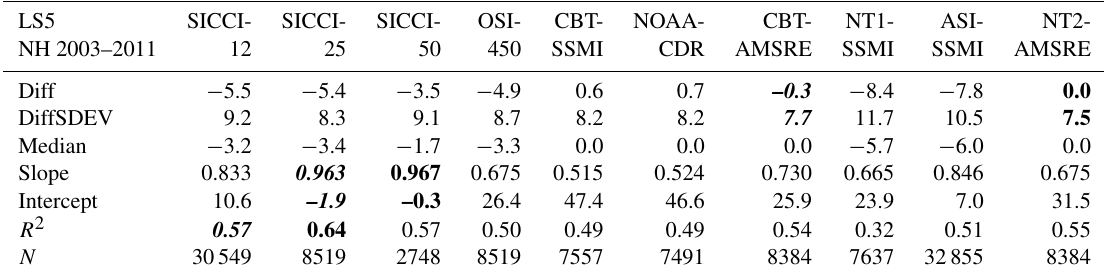
Table 5. Summary of the statistical parameters displayed in Fig. 2. Diff, DiffSDEV, and Median (all in percent SIC) are the mean difference PMW SIC minus Landsat (LS) SIC, its standard deviation, and the median difference, Slope and Intercept (in percent SIC) are the coefficients of the linear regression, and R 2 and N are the squared linear correlation coefficient and number of data pairs, respectively. Numbers in bold and bold italic font denote the respective “best” and “second best” value, respectively, e.g., largest and second largest values of R 2 and lowest and second lowest values of Diff, Intercept, and the difference of unity minus slope.